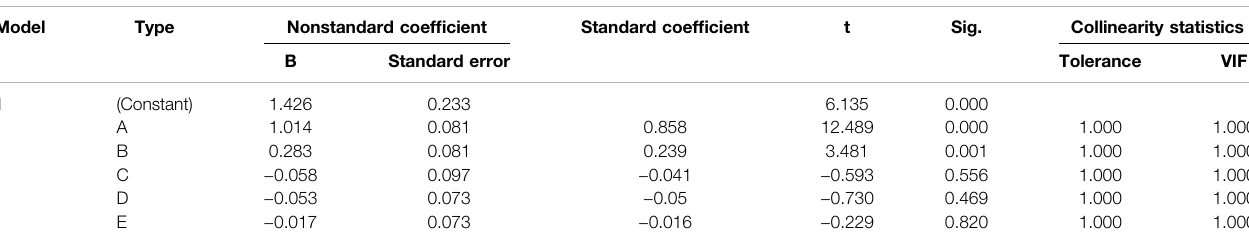
TABLE 7 | Coef fi cient